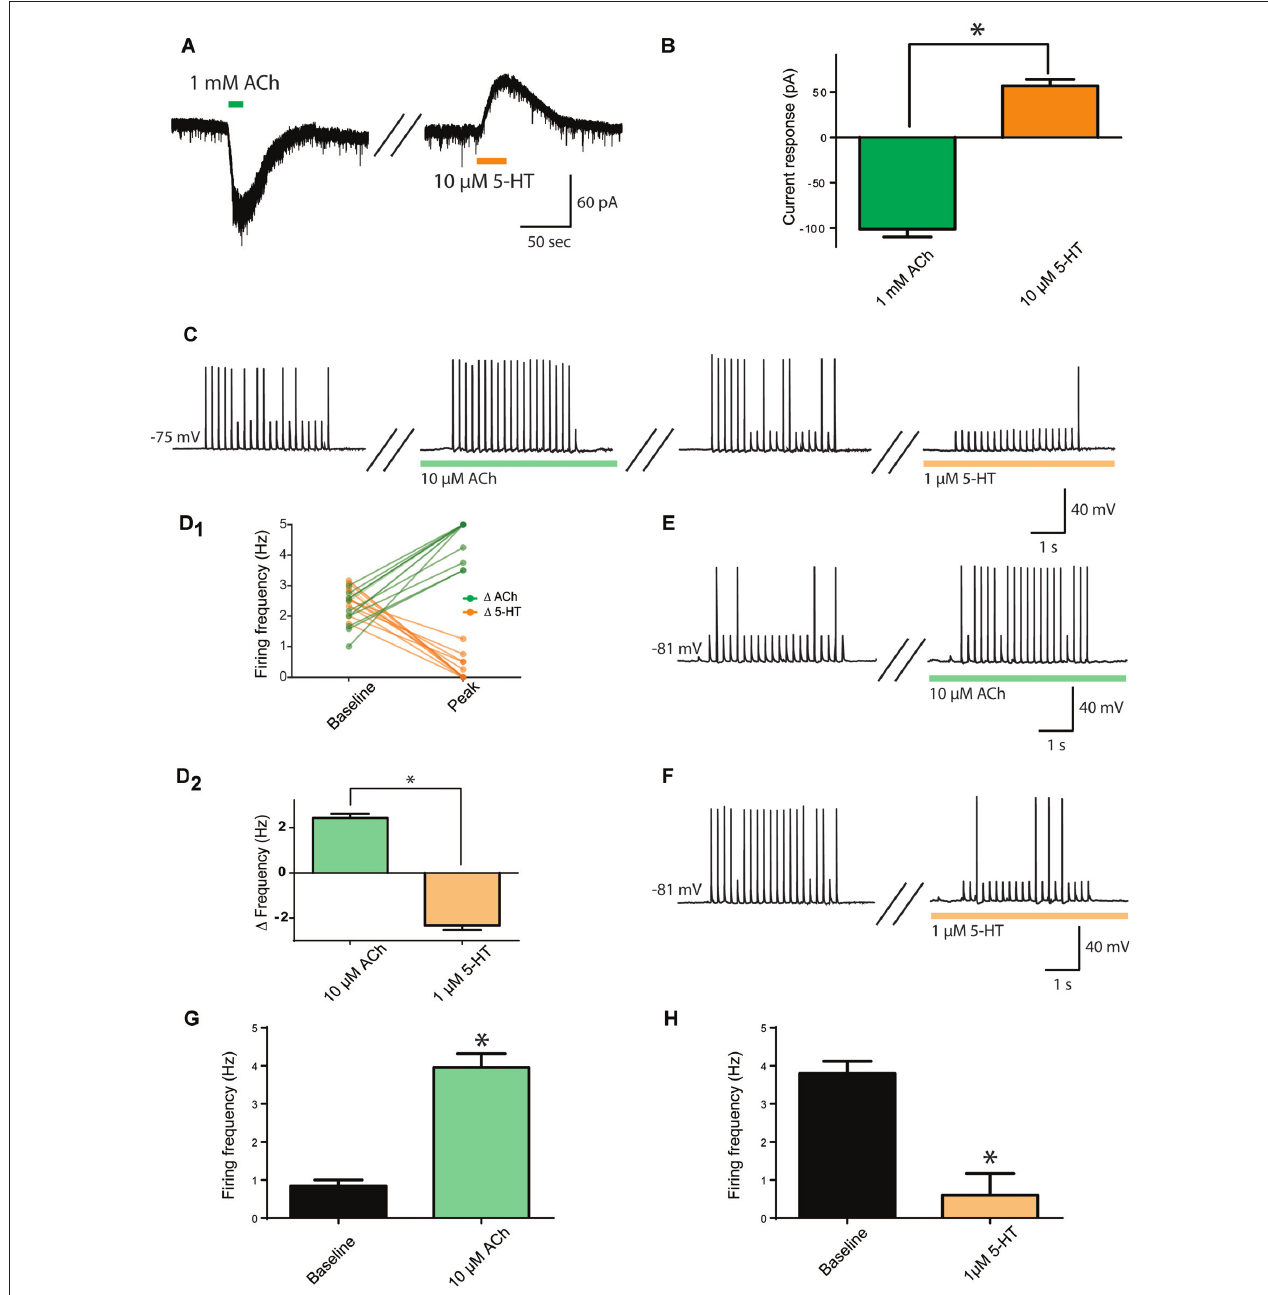
FIGURE 1 | Opposing cholinergic and serotonergic modulation of prefrontal layer 6 neurons. (A) Example voltage-clamp recording showing inward current elicited by strong acetylcholine (ACh) stimulation (1 mM) and outward current elicited by strong serotonin (5-HT; 10 µ M) stimulation in the same layer 6 neuron. (B) Bar graph summarizing inward and outward currents elicited by ACh and 5-HT respectively in layer 6 pyramidal neurons ( t 9 = 13.7, p < 0.0001). (C) To assess the effects of lower stimulation by ACh and 5-HT on firing frequency, a train of peri-threshold current pulses was delivered to layer 6 pyramidal neurons. Example neuron shows the frequency of action potentials elicited compared across baseline, ACh (10 µ M), washout, and 5-HT (1 µ M) conditions. (D) Linked-data plot (D 1 ) and bar graph (D 2 ) summarize the change in frequency of action potentials fired in response to ACh and 5-HT respectively in layer 6 pyramidal neurons ( t 11 = 15.3, p < 0.0001). The strength of this modulation raises the possibility of ceiling and floor effects. (E) Therefore, to probe further the ability of ACh (10 µ M) to enhance action potential firing, a train of current pulses with lower spike probability was used, as shown in this example. (F) Furthermore, to probe further the ability of 5-HT (1 µ M) to suppress action potential firing, a train of current pulses with greater spike probability was used, as shown in this example. (G) Bar graph summarizing the spike frequency enhancing effects of a low level of exogenous ACh ( t 18 = 7.57, p < 0.0001). (H) Bar graph showing the spike frequency suppressing effects of a low level of 5-HT ( t 6 = 5.4, p = 0.0016). ∗ Denotes p < 0.05. Darker green and orange indicate higher concentration of ACh and 5-HT (1 mM and 10 µ M, respectively), while lighter green and orange indicate lower concentration of ACh and 5-HT (10 µ M and 1 µ M, respectively).